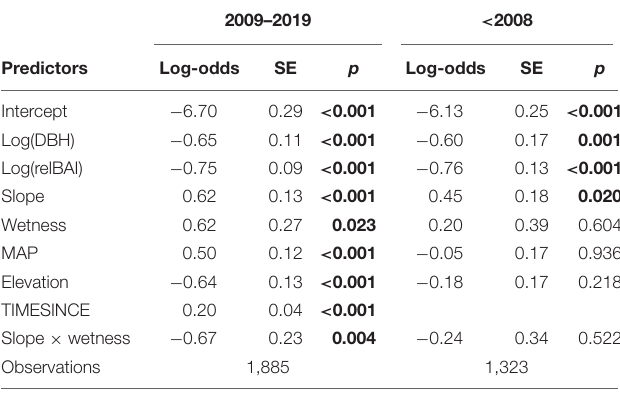
TABLE 1 | Parameters of generalized linear model of mortality probability (MP) based on data of the